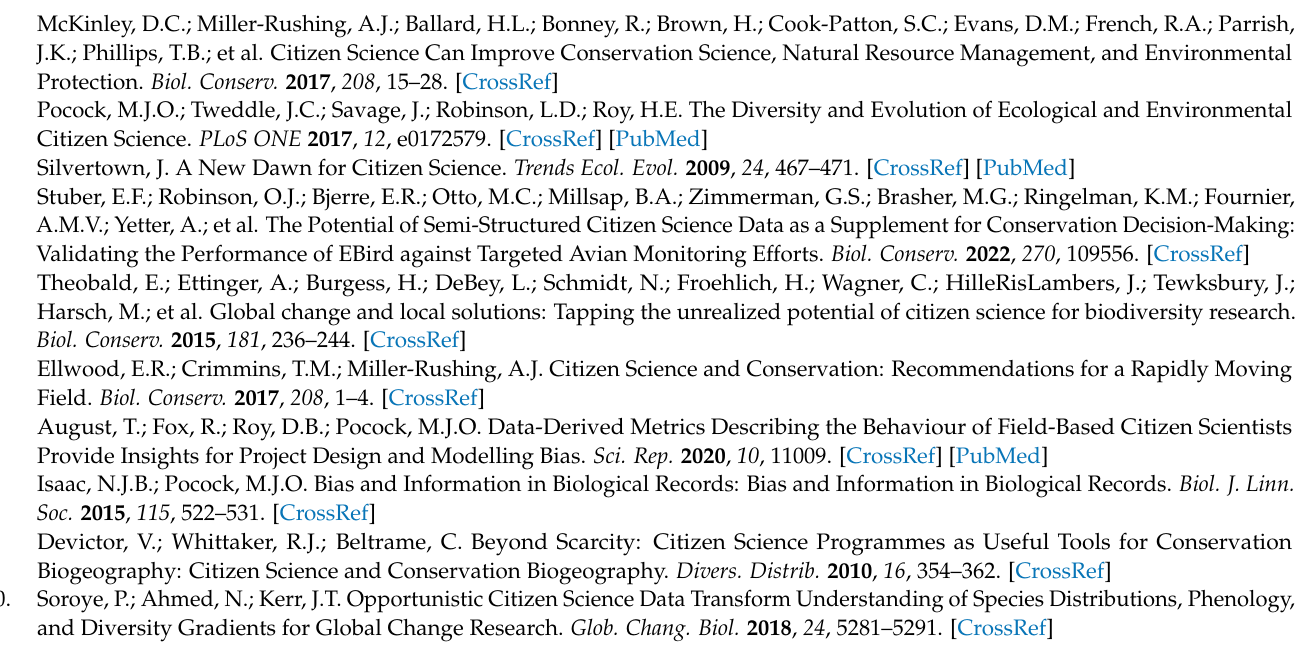
Figure A6. Violin plots of the mean NI of records from the four observer profiles (garden-watcher, beginner, naturalist, and expert) focusing on very low RI class ( top left ), low RI class ( top right ), high RI class ( down left ), and very high RI class ( down right ). Shapes of violin represent the kernel density of the NI data records.